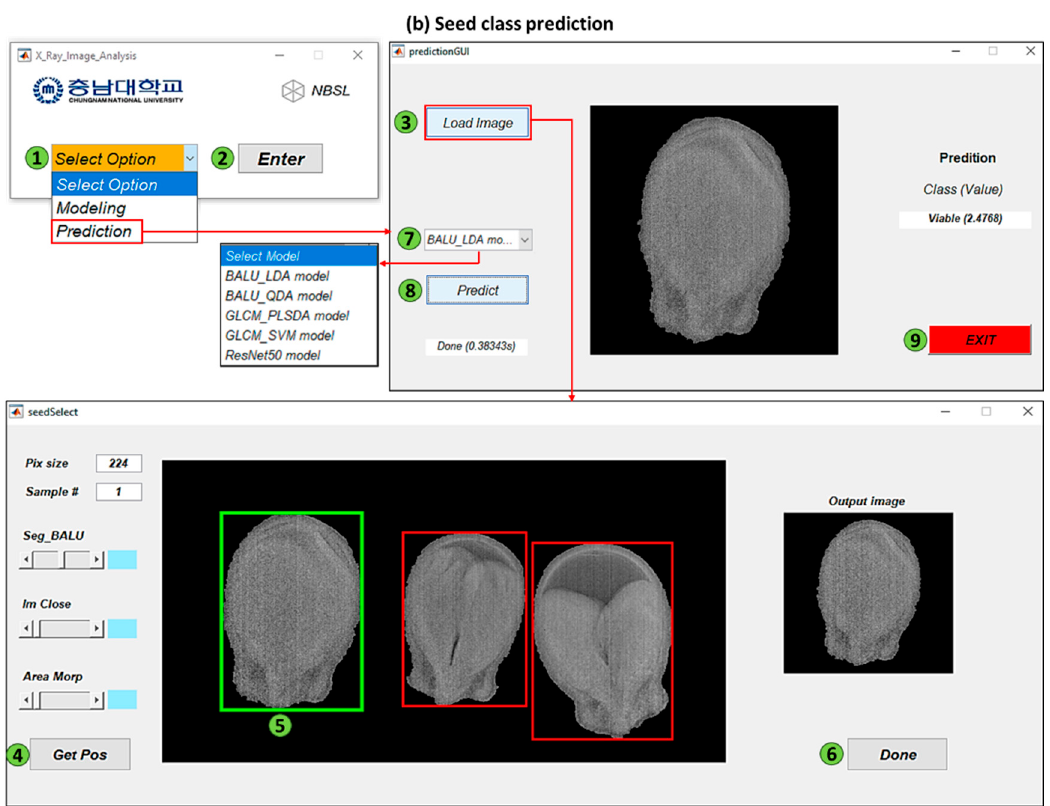
Figure 4. A custom-built software for classification ( a ) and prediction ( b ) of seed based on their morphology using X-ray imaging where green circles with number show the sequence of the operations.